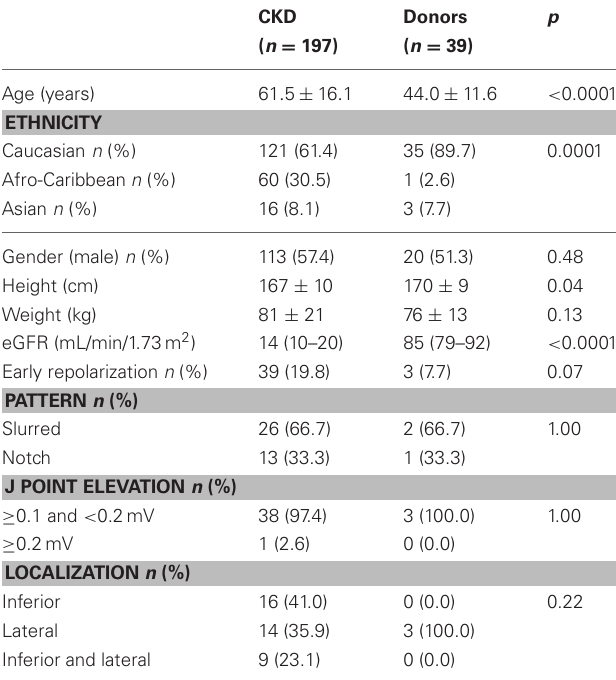
Table 3 | Comparison of baseline characteristics of adults with ER vs. those without